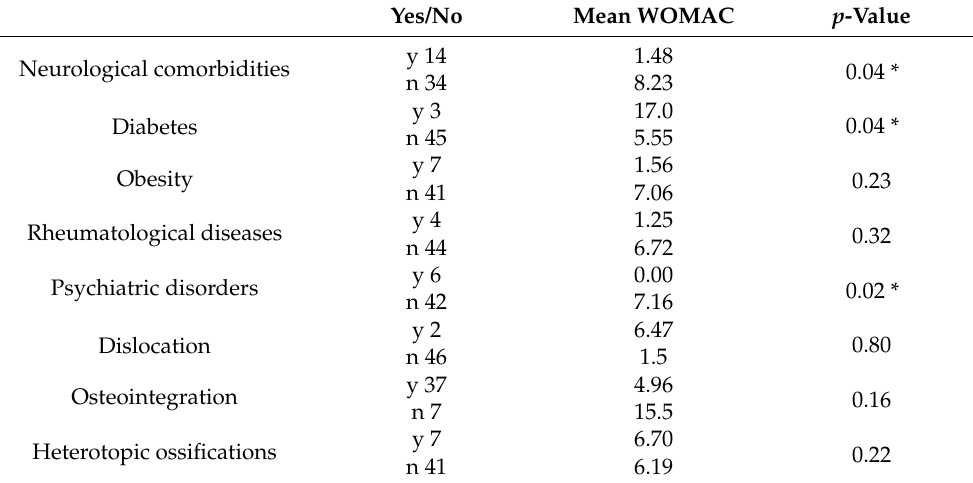
Figure 2. ( a ) Postoperative radiograph of a DMC showing (arrows) a radiolucent line at the bone- implant interface. ( b ) Radiographic evidence of implant osteointegration one year after surgery. Correlations between the WOMAC score and clinical-radiographic variables in the total population are shown in Table 2. Table 2. Correlations between the WOMAC score and clinical-radiographic variables at follow up.